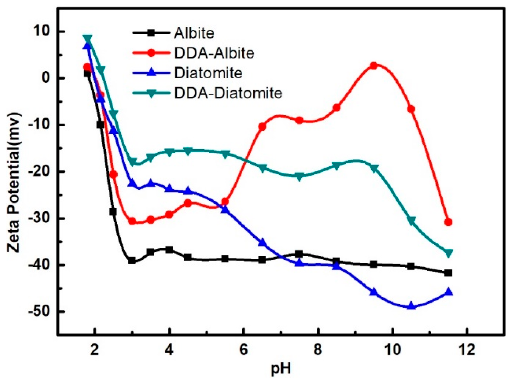
Figure 4. Zeta potentials of diatomite and albite.